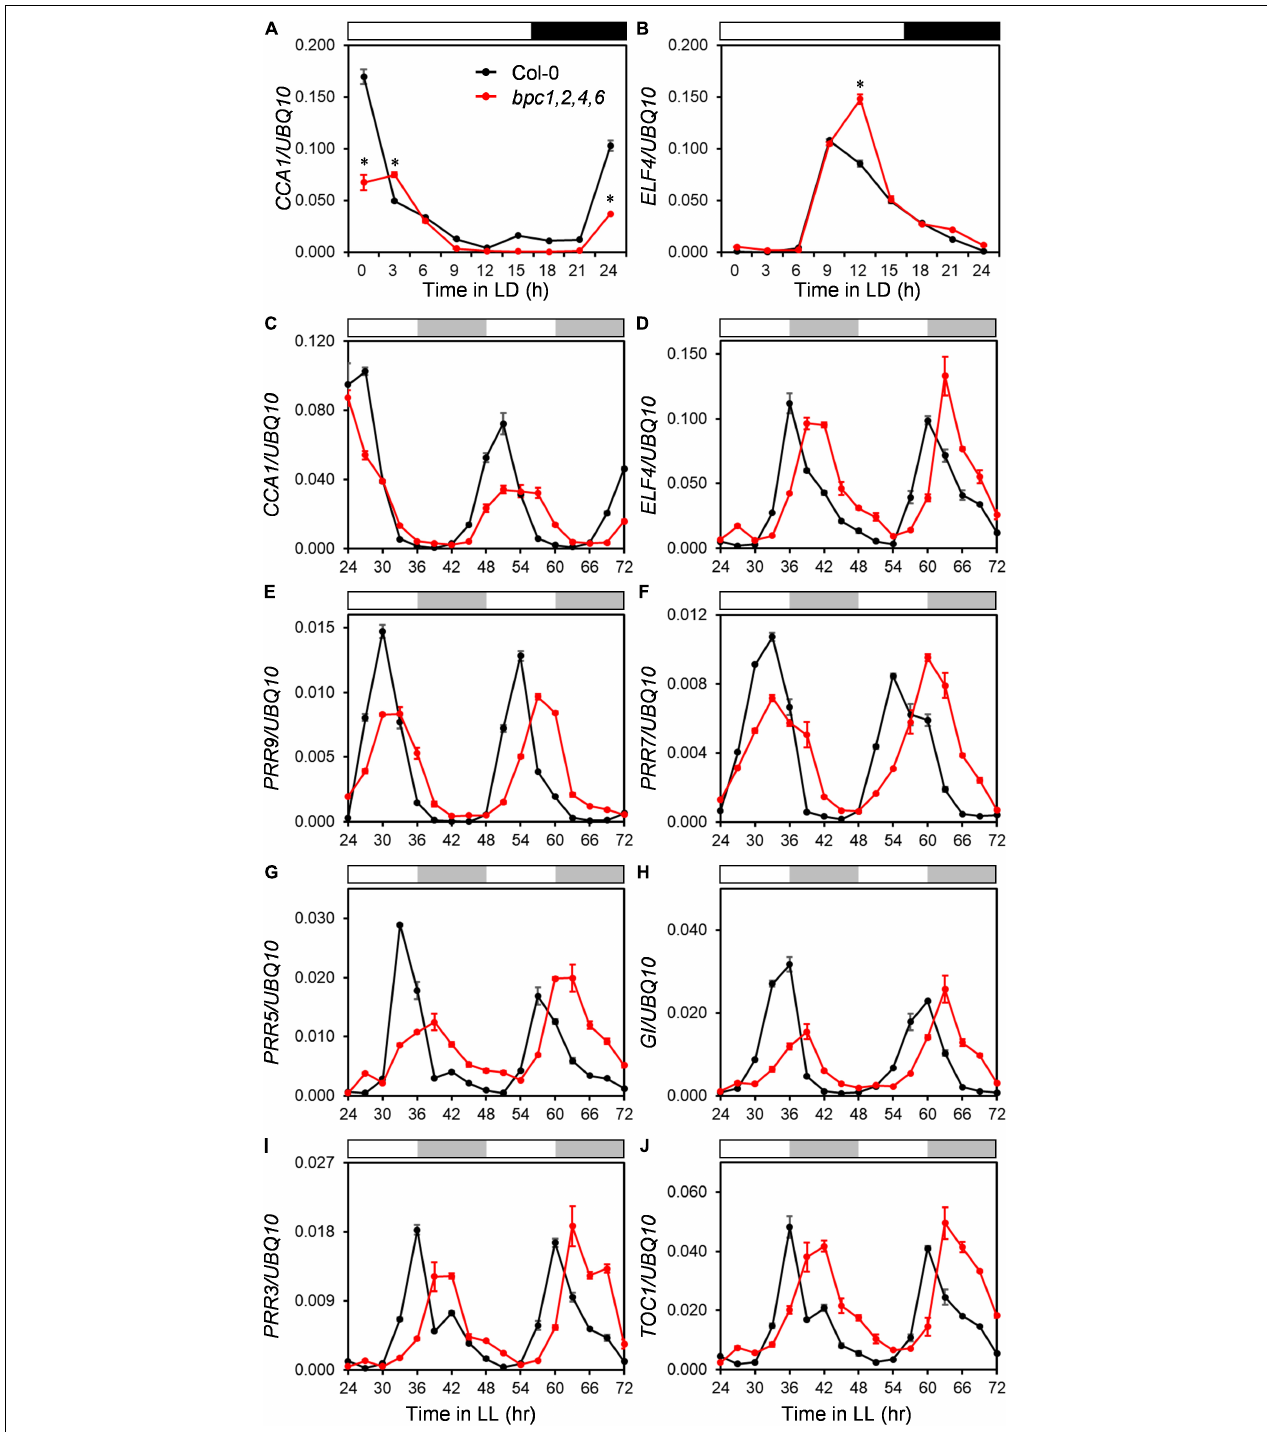
FIGURE 4 | The expression of clock genes are phase-delayed in the bpc1-1 bpc2 bpc4 bpc6 mutant. (A,B) Eighteen-day-old wild-type (Col-0) and bpc1-1 bpc2 bpc4 bpc6 ( bpc1,2,4,6 ) plants grown under long day (16-h light/8-h dark) were harvested at indicated ZT for profiling circadian clock representative morning gene CCA1 (A) and evening gene ELF4 (B) . qRT-PCR analyses were conducted, data are mean ± S.E. ( n = 3 technical replicates). Asterisks indicate CCA1 transcript levels were significantly altered in mutants (Student’s t- test; ∗ P < 0.01). (C–J) Eighteen-day-old plants grown under midday (12-h light/12-h dark) were transferred to the constant light (LL) and harvested at 3-h intervals from LL24h to LL72h for CCA1 (C) , ELF4 (D) , PRR9 (E) , PRR7 (F) , PRR5 (G) , GI (H) , PRR3 (I) , and TOC1 (J) profiling by qRT-PCR analyses. Data are mean ± S.E. ( n = 3 technical replicates; one independent biological replicate was presented in Supplementary Figure 6 ). White, black, and gray bars denote the light, dark, subjective light, and subjective darkness, respectively.